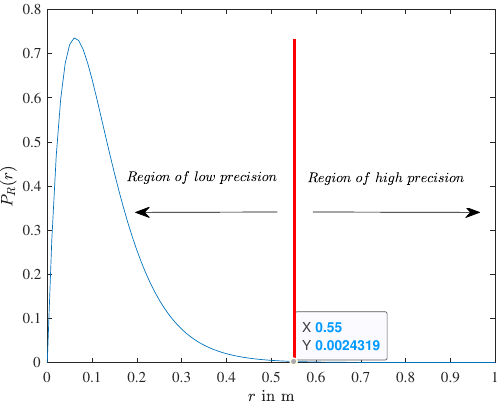
Figure 5. Error probability followed by the distance. As it is shown in Figure 5, the precision of the proposed method is robust when we are approaching the barrier of one meter. The precision becomes weak while approaching the origin. At distance greater than 0.55 m the error probability tends to the